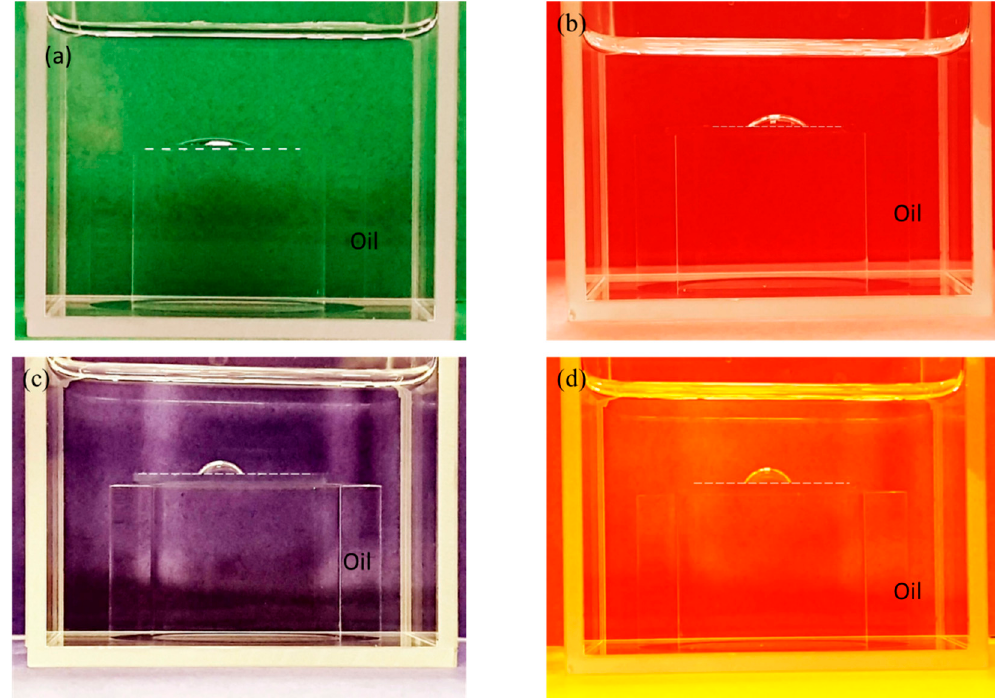
Figure 8. Images of sessile drop on glass slides coated with 1 wt% nanoclay with CTAB concentrations of: ( a ) 0, ( b ) 0.01, ( c ) 0.03, and ( d ) 0.05, immersed in the oil phase.